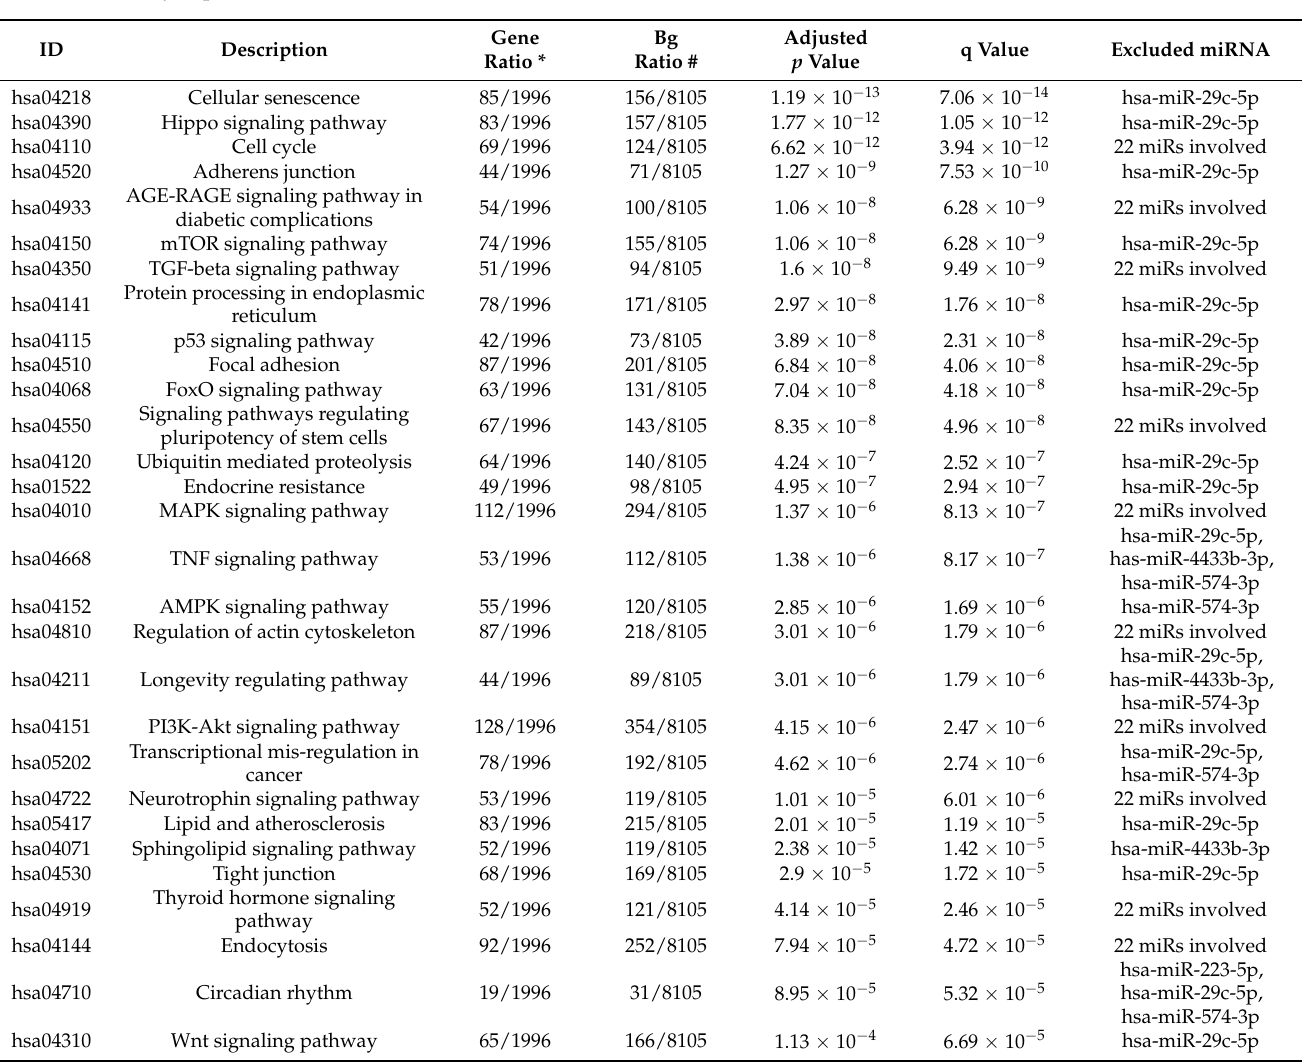
Table 2. Enriched Kyoto Encyclopedia of Genes and Genomes (KEGG) pathways for predicted target genes of the 22 differentially expressed